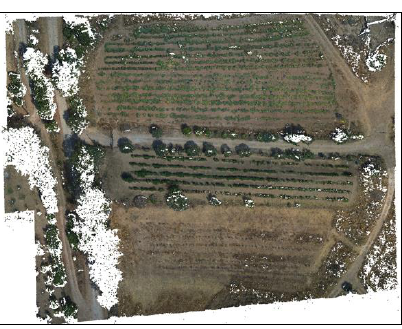
Figure 10. Dense point cloud - 50 m